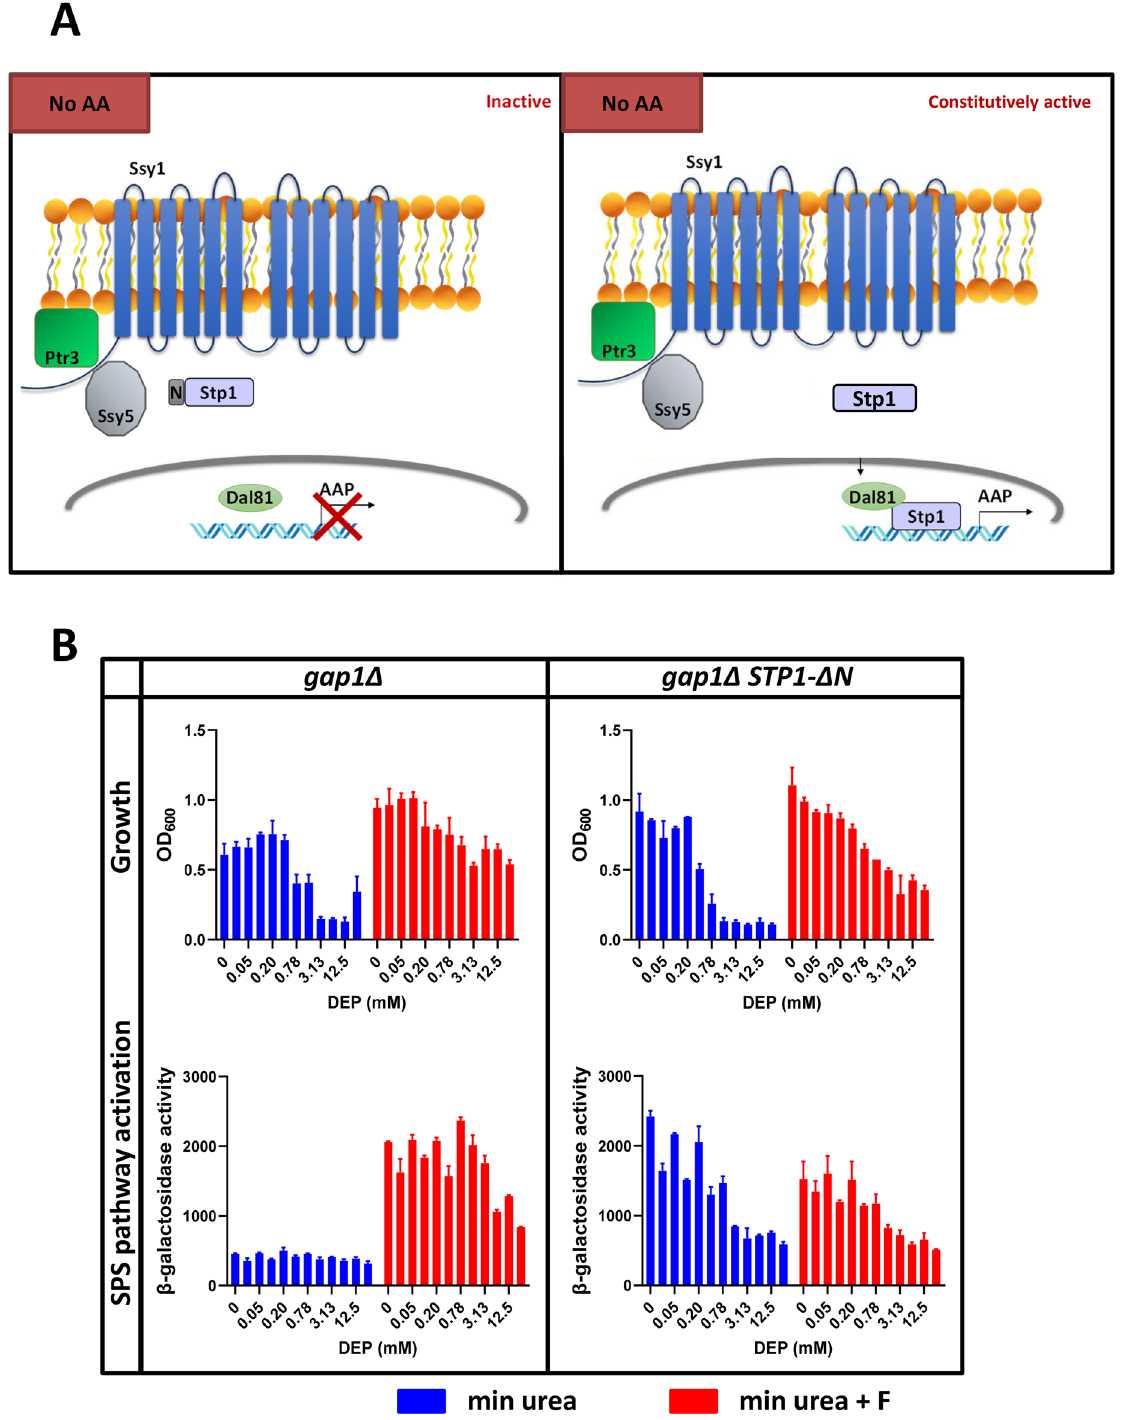
Figure 6. Constitutive activation of SPS pathway does not rescue DEP toxicity. ( A ) Schematic diagram comparing the inactive SPS pathway and constitutively activated SPS pathway in the absence of amino acids. ( B ) Constitutive activation of SPS pathway from Stp1ΔN in presence and absence of phenylalanine (5 mM). The reported values for OD 600 and β-galactosidase activities in gap1Δ and gap1Δ STP1ΔN (Σ1278b background) are obtained from two independent experiments (mean ± SD). Two-fold serial dilution of DEP (maximum concentration at 25 mM) was